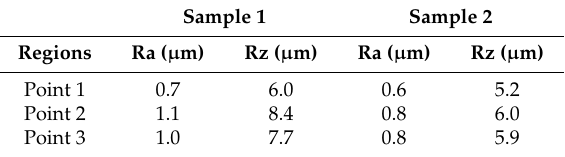
Table 10. Micrometric roughness values obtained by a linear roughness meter in July 2020.